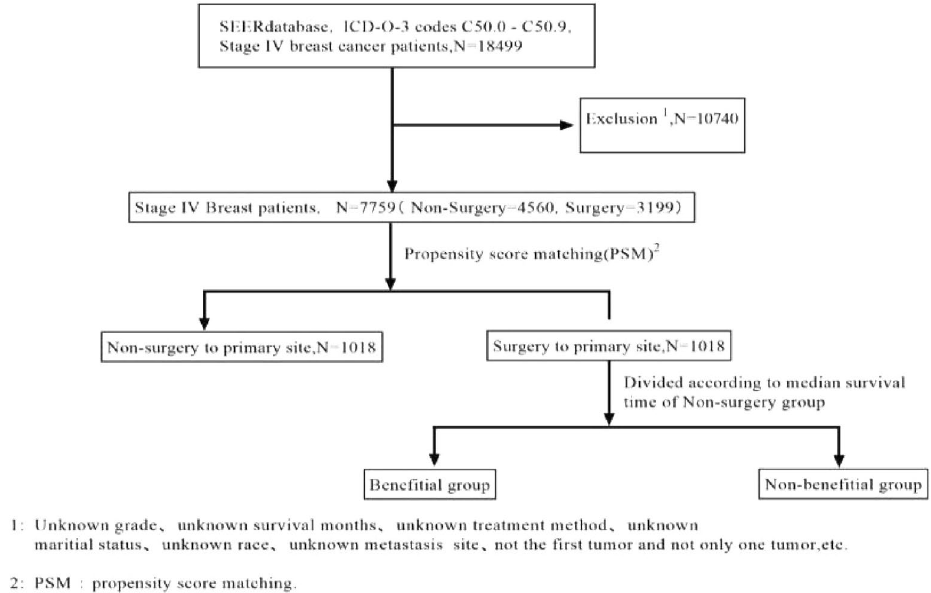
Figure 1. A flow diagram showing the study selection